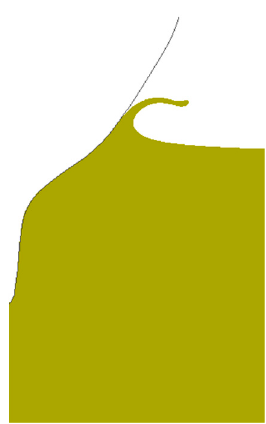
Figure 20. Water entry of the stern at the full load condition ( t = 1.4 s).